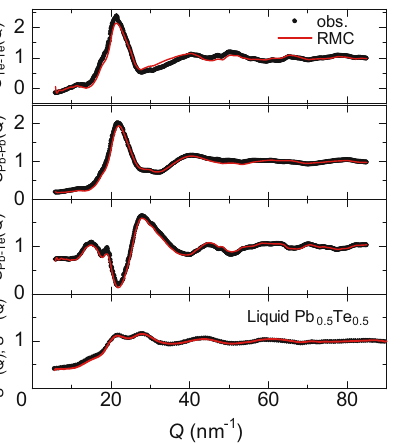
RMC ’ s obtained from ij